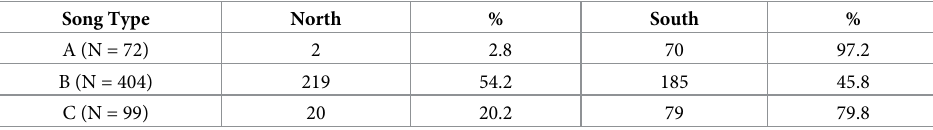
Table 5. Percentage of each song type distributed north and south of the Last Glacial Maximum